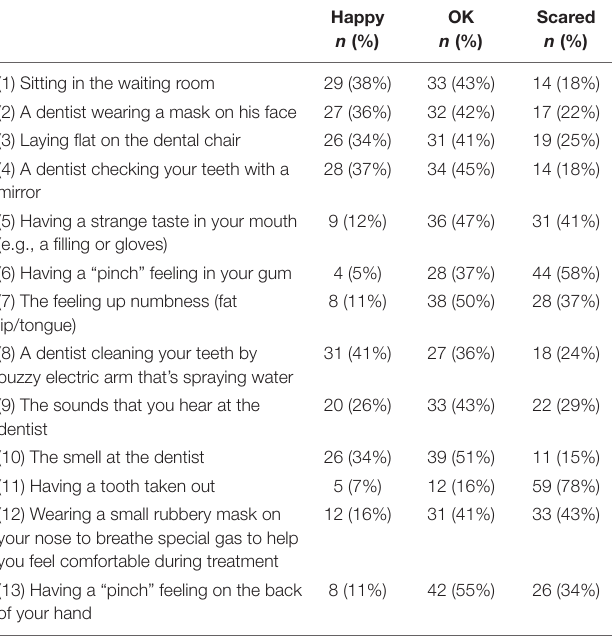
TABLE 2 | Item responses to Abeer Child Dental Anxiety Scale ( n =